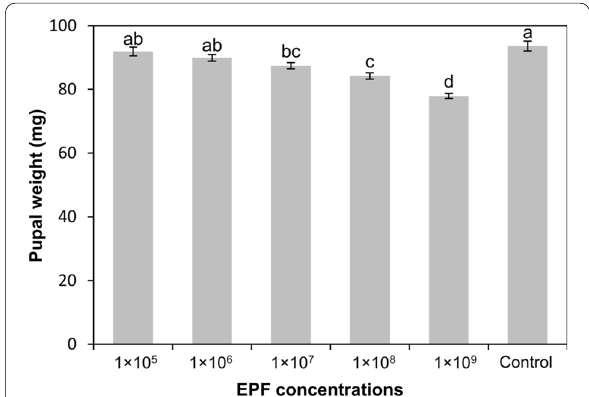
Fig. 2 Effect of various conidial concentration of Metarhizium anisopliae on pupal weight (mg